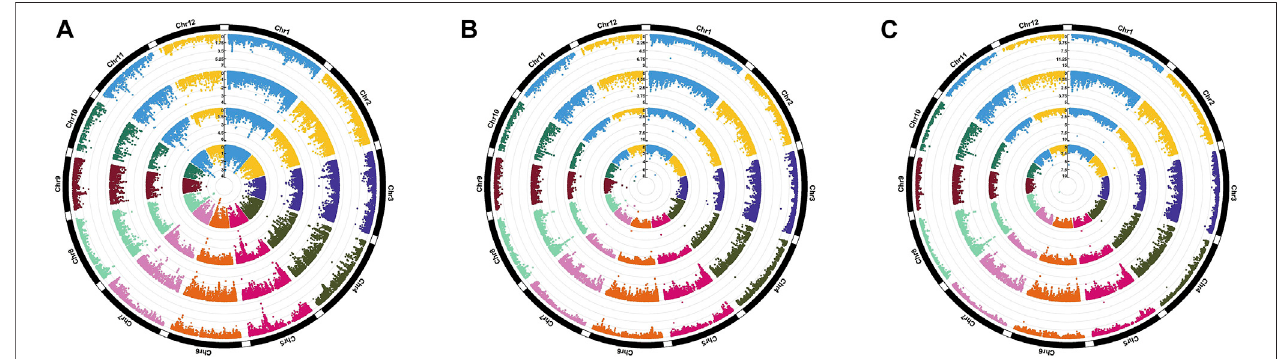
FIGURE 4 | Circular Manhattan plots depicting signi fi cant MTAs using MLM (A) , FarmCPU (B) , and BLINK (C) for various traits. From outside to inside: grain yield per plant (GYPP) under stress, spikelet fertility (SF) under stress, STI calculated for GYPP, and STI calculated for SF.